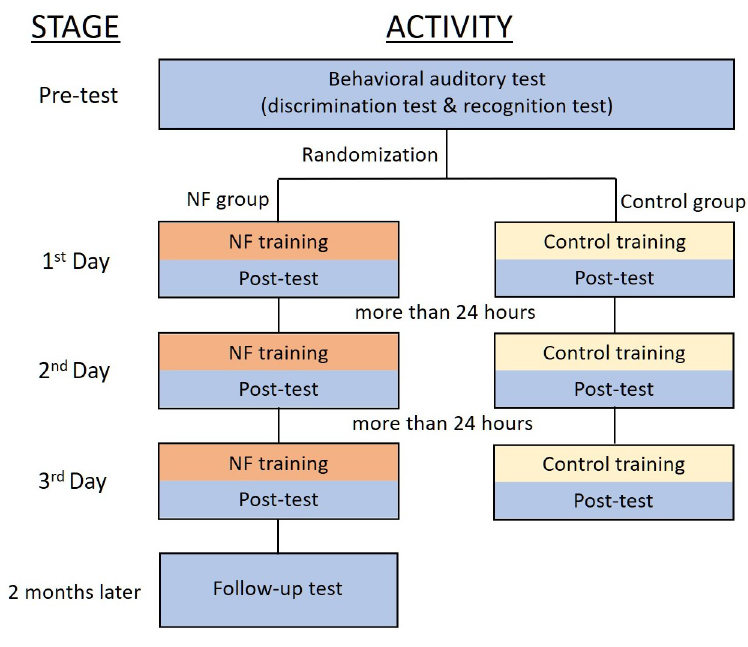
Fig 1. Overall study